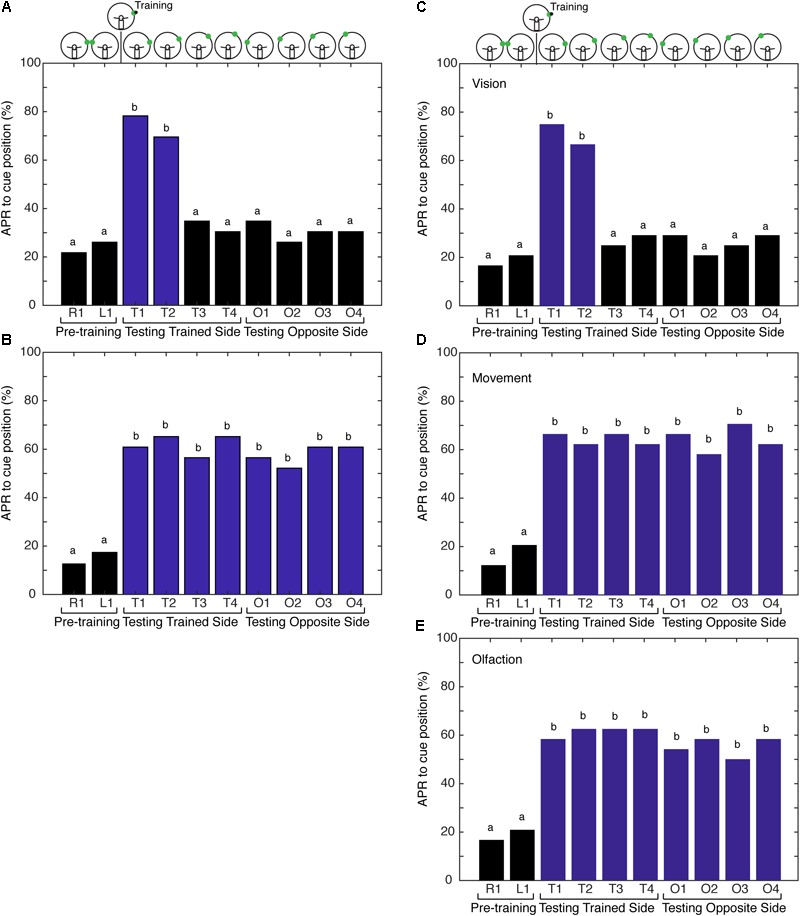
Comparison of antennal projection responses (APRs) using non-restricted, restricted, and semirestricted sensory conditions. (A) The APRs of cockroaches (n = 23) that were trained in the non-restricted sensory condition and tested on the trained side (T1–T4) and the opposite side (O1–O4). The pretraining APRs were not significantly different (z = –0.327, P = 0.7437). The APRs were significant when presented at the different trained positions (T1–T4) (χ2 = 27.15, P = 5.46E-6). Cockroaches demonstrated significant APRs when the CS was presented within 15° of the learned position (T1 and T2) (χ2 = 33, P = 3.23E-7), with no differences in the response to T1 vs. T2 (z = 0.6498, P = 0.5158). APRs were not different from pretraining when tested at other positions (T3 and T4 – χ2 = 6, P = 0.116; O1–O4 – χ2= 4, P = 0.2615). (B) APRs of cockroaches (n = 24) trained in the restricted sensory condition. The pretraining APRs were not significantly different (z = –0.3883, P = 0.6978). The APRs toward the CS were significantly different from pretraining (χ2 = 79.64, P = 1.9E-13), but were not different from each other at any of the positions (T1–T4 – χ2 = 12.35, P = 0.0895 and O1–O4 – χ2 = 8.68, P = 0.1223). (C) The APRs of cockroaches (n = 24) trained in the vision semi-restricted sensory condition. The pretraining APRs were not significantly different (z = –0.351, P = 0.7258). The APRs were significantly different between the tests (χ2 = 68.44, P = 3.045E-12). The APRs to the CS that was within 15° of the learned position (T1 and T2) were different from pretraining (χ2 = 135.95, P = 7.7E-8), but not each other (z = 0.6154, P = 0.5383). APRs were not significant at other locations (T3 and T4 – χ2 = 3.0, P = 0.2232; O1–O4 – χ2 = 7.3333, P = 0.1193). (D) APRs of cockroaches (n = 24) trained in the antenna movement semi-restricted sensory condition. The pretraining APRs were not significantly different (z = –0.7505, P = 0.4529). The APRs elicited to the CS positions were significantly different from pretraining (χ2 = 91.5, P = 8.14E-16), but were not different from each other (T1–T4 and O1–O4; χ2 = 11.2, P = 0.1301). (E) APRs of cockroaches (n = 24) trained in the olfaction semi-restricted sensory condition. The pretraining APRs were not significantly different from each other (z = –0.351, P = 0.7258). The APRs elicited to the CS positions were significantly different from pretraining (χ2 = 73.59, P = 3.00E-12), but were not different from each other (T1–T4 and O1–O4; χ2 = 13.18, P = 0.0679). Bar colors and letters reflect statistical groups. Illustration above graphs represents the position of cues during experiment.